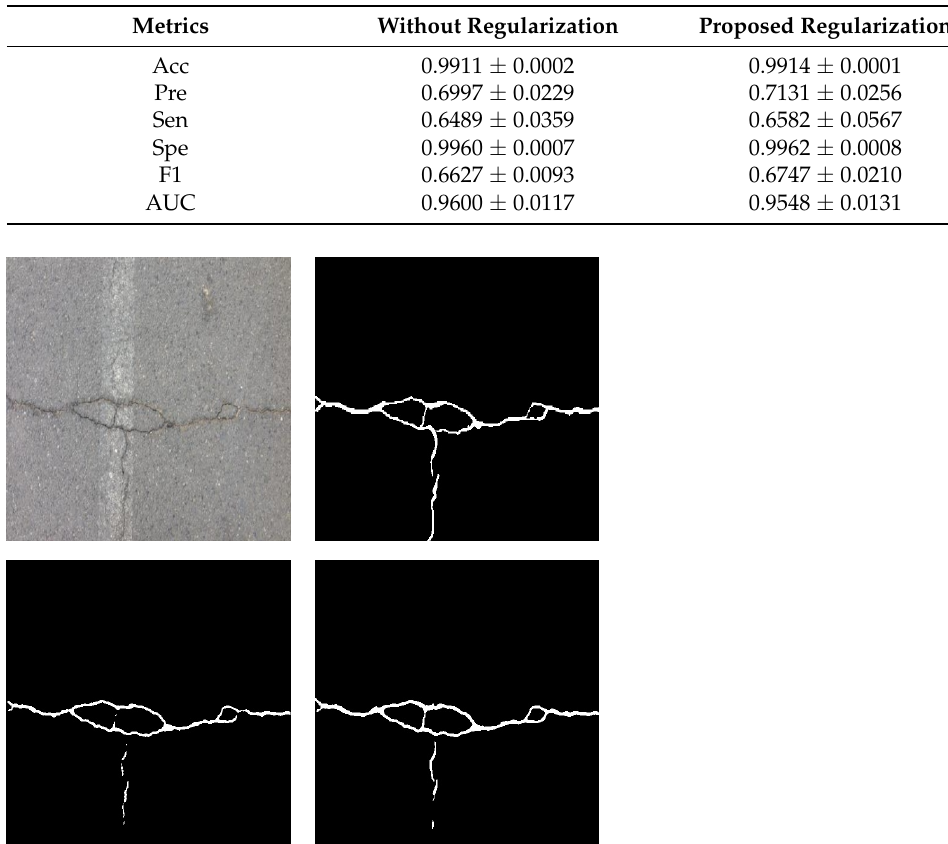
Table 1. Results of CFD dataset with and without regularization.